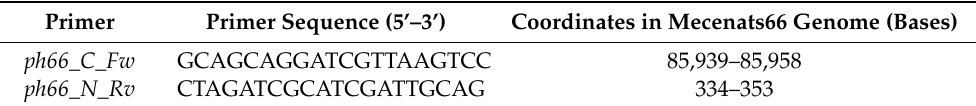
Table 2. Custom primers designed to elucidate the physical genome molecule termini of the phage Mecenats66. Primer Primer Sequence (5’–3’) Coordinates in Mecenats66 Genome